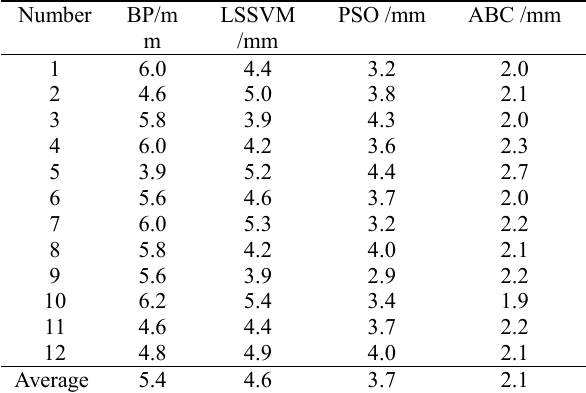
Figure 3. Residual comparison of four fitting